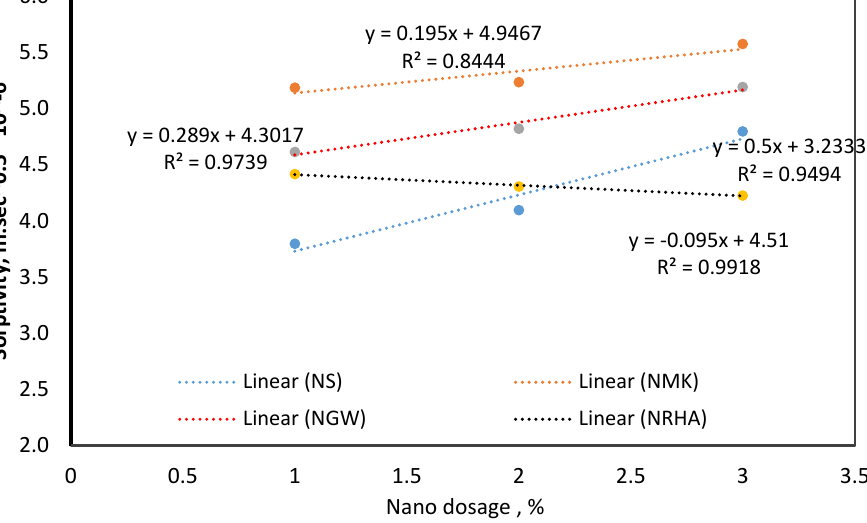
Figure 9. Accumulative sorptivity results of various UHPC specimens at 28 days of curing.